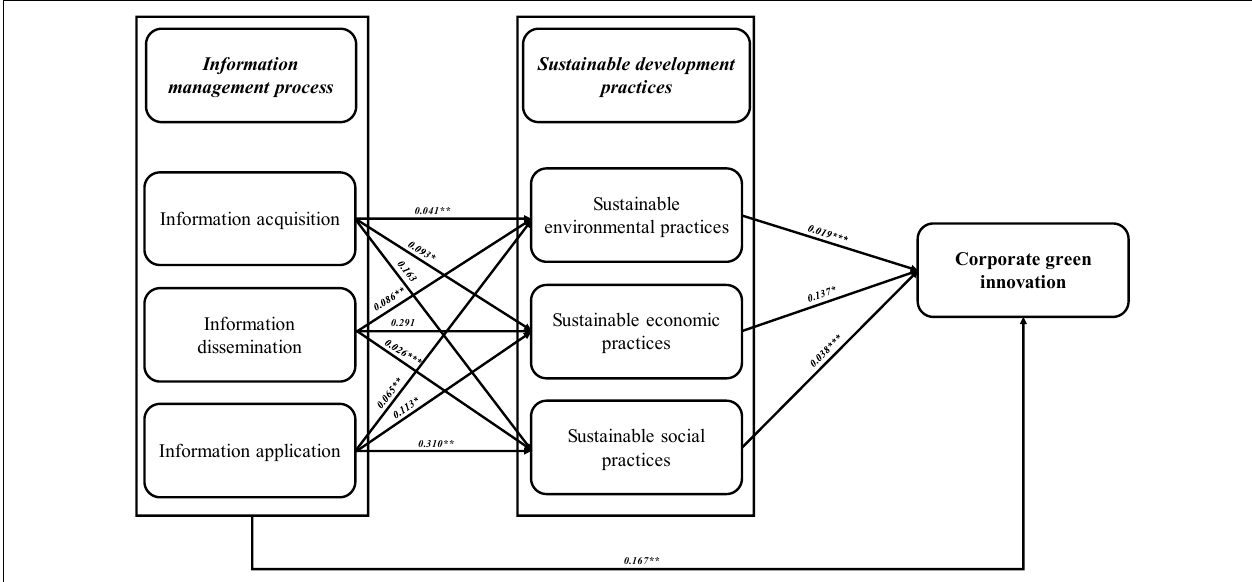
FIGURE 2 | Path diagram of structural equation modeling (SEM). *** p < 0.01, ** p < 0.05, * p < 0.1.